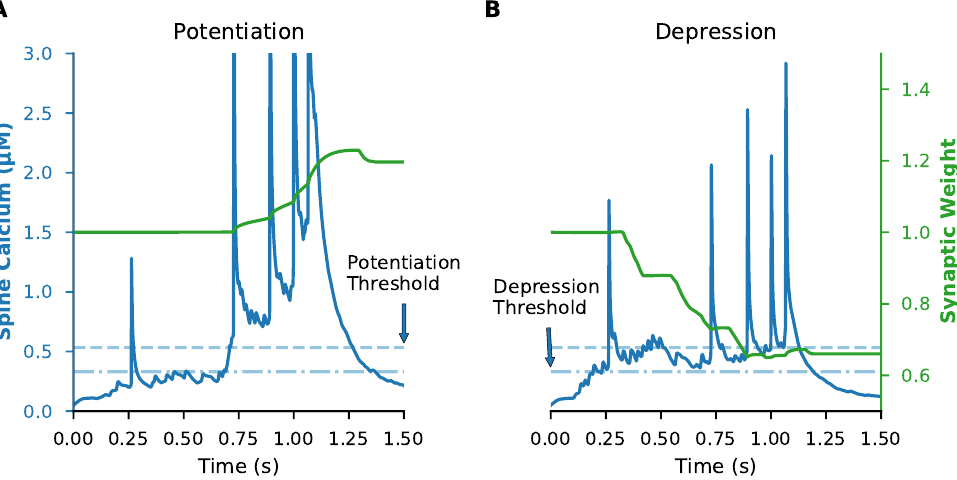
Figure 3. Calcium-based plasticity rule produces both potentiation and depression. A calcium-based plasticity rule was implemented with dual amplitude and duration thresholds. LTD required that spine calcium concentration exceed the amplitude threshold (dot-dashed line) of 0.33 µ Molar for greater than 28 ms, while LTP required that spine calcium concentration exceed a higher amplitude threshold (dashed line) of 0.53 µ Molar for at least 3.3 ms. Example traces are shown of a synapse that potentiates ( A ) or depresses ( B ) following a single trial. Blue lines show spine calcium concentration (with left y-axis) and green lines show synaptic weight (with right y-axis) for each example